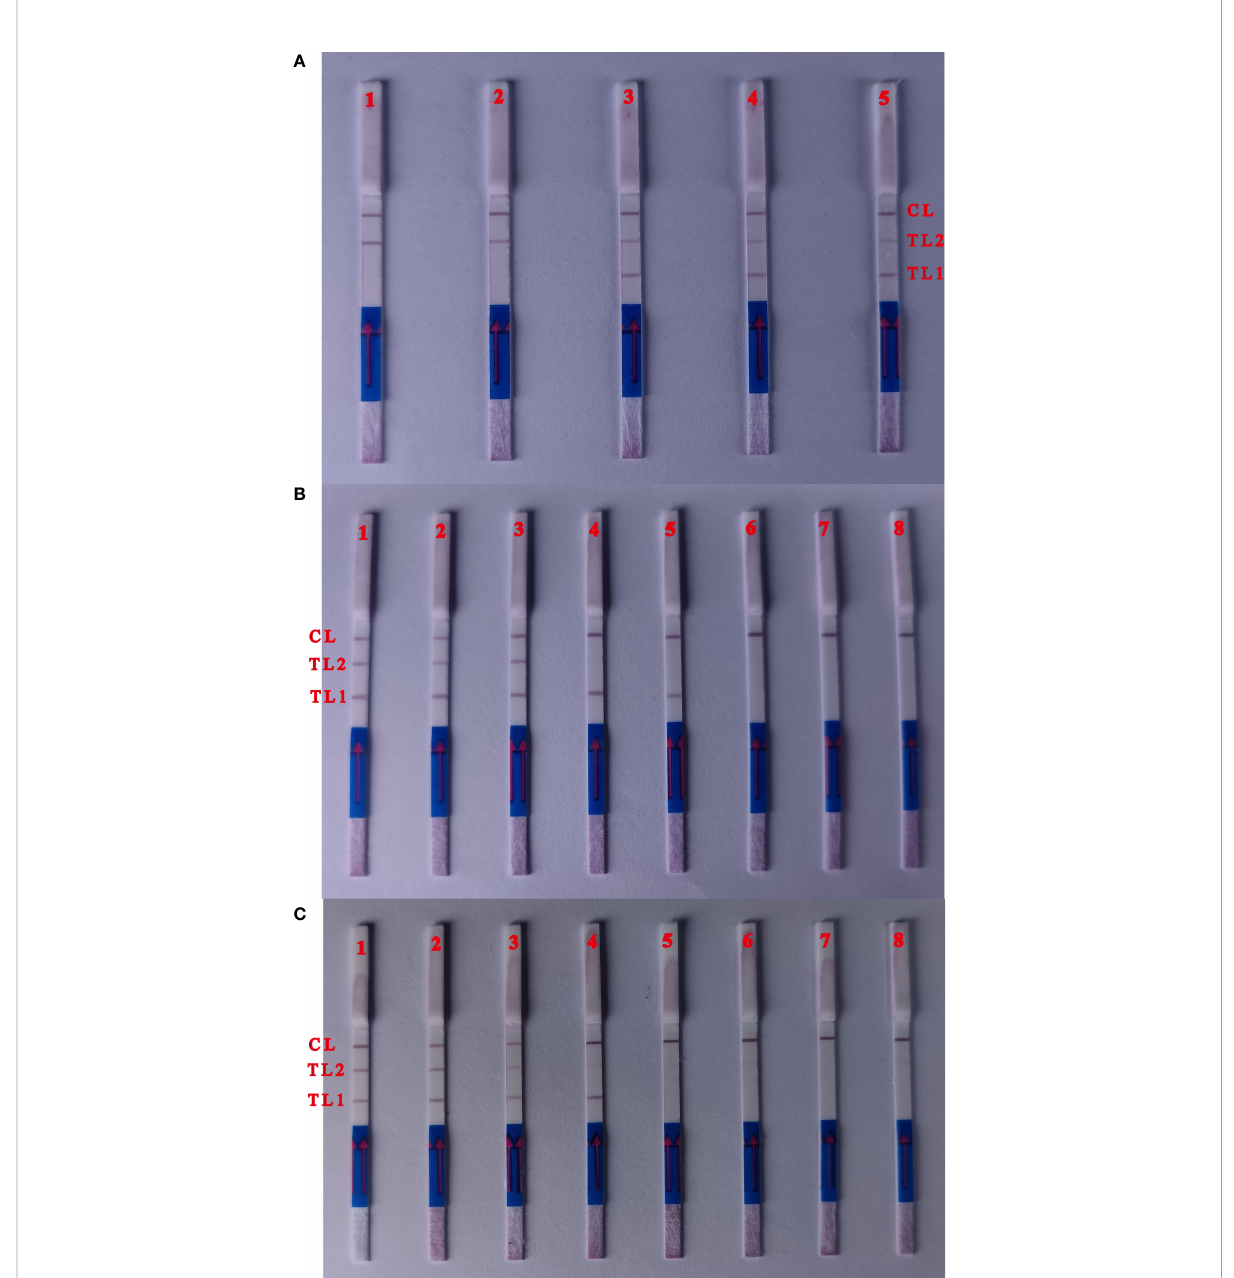
FIGURE 3 Optimization of the ratio of two primers and detection limit of multiple targets MCDA assay. (A) Biosensors 1, the primer concentration with 0.2 m L ipaH gene primers mix and 2.0 with m L wbgX gene primers mix; biosensors 2, 0.4 m L ( ipaH gene) and 1.8 m L ( wbgX gene); biosensors 3, 0.6 m L ( ipaH gene) and 1.6 m L ( wbgX gene); biosensors 4, 0.8 m L ( ipaH gene) and 1.4 m L ( wbgX gene); biosensors 5 1.0 m L ( ipaH gene) and 1.4 m L ( wbgX gene). Two red test lines appeared from the primer concentrations with 0.6 m L ipaH gene 1.6 m L wbgX gene primers mixtures. (B) The sensitivity of multiple MCDA-LFB reactions with the serial dilutions genomic DNA of S. sonnei CMCC 51081. Biosensors 1 – 6, multiple MCDA results for six dilutions including 10 ng, 10 pg, 1 pg, 100 fg, 10 fg, and 1 fg; Biosensor 7, negative control; Biosensor 8, blank control. The sensitivity of multiple MCDA reactions was 1 pg/ m L (positive results of Biosensors 3). The positive results could observe at Biosensors 5 with the concentration of 10 fg/ m L with ipaH gene in the multiple MCDA reactions. No red test lines could be observed with negative control and blank control. (C) The sensitivity of the multiplex MCDA assay in arti fi cially contaminated human feces samples. Biosensors 1 – 6: S. sonnei CMCC 51081 strain at 3700 CFU, 370 CFU, 37 CFU, 3.7 CFU, 0.37 CFU and 0.037 CFU per reaction; Biosensor 7, negative control; Biosensor 8, blank control. The positive results were detected for samples containing 37 CFU per reaction, and the red test lines of ipaH gene appeared in the sample with 3.7